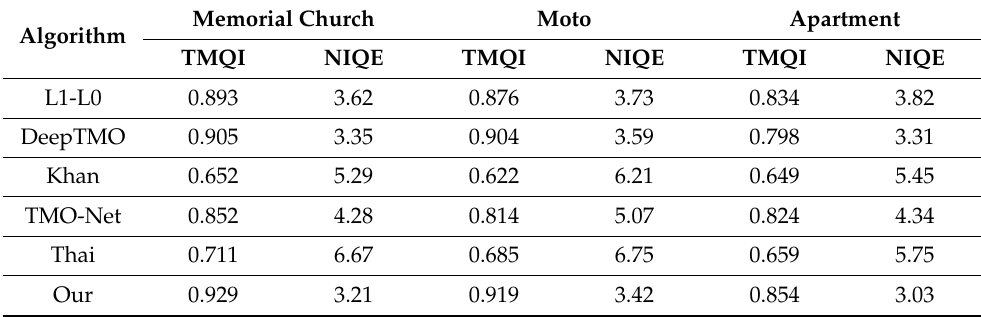
Table 1. Objective evaluations using 6 tone mapping algorithms and 3 radiance maps.